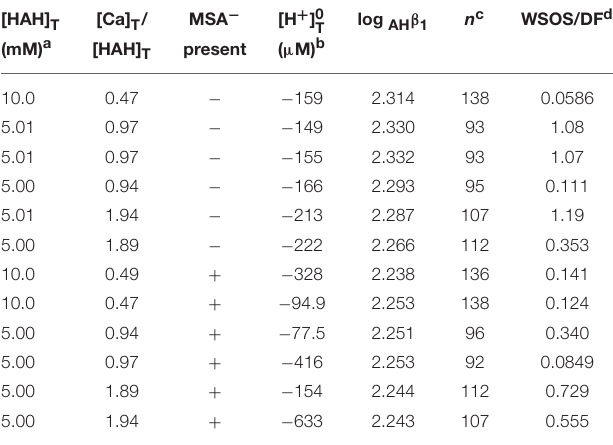
TABLE 5 | Stability constants for AH and MSA complexes of Mg and Ca, derived from potentiometric titrations. Constant H Mg